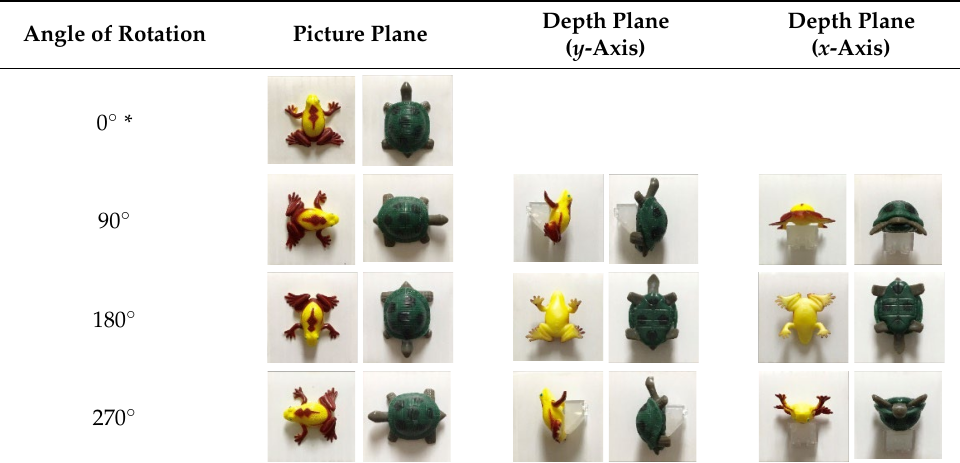
Table 1. Stimuli.